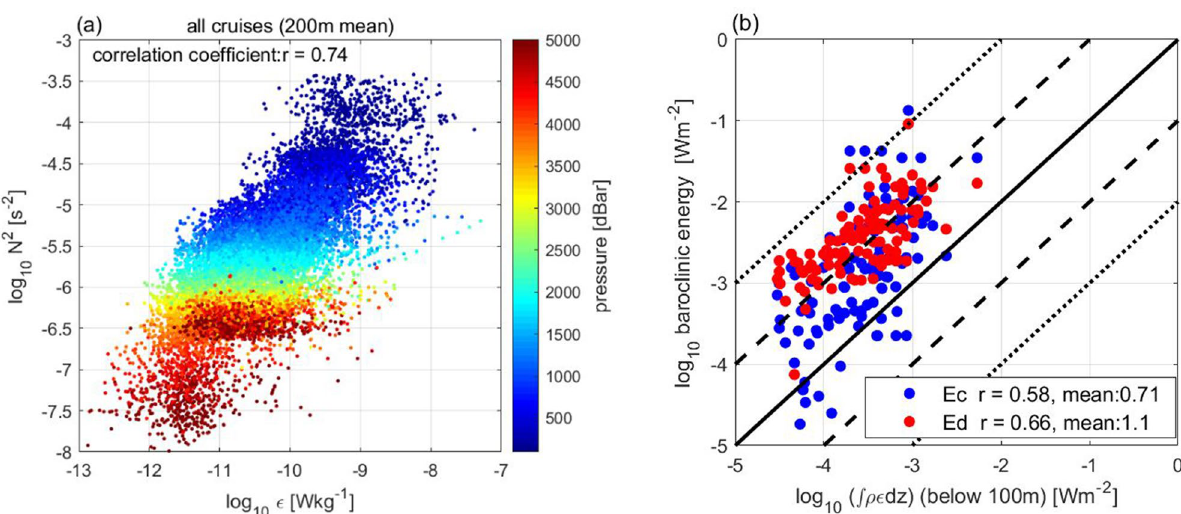
Figure 3. Relationship between ε and N 2 and baroclinic tide energy. ( a ) Relationship between the observed energy dissipation, ε , and the squared buoyancy frequency, N 2 . Colours denote pressure. ( b ) Relationship between depth-integrated observed energy dissipation, ∫ ρε d z , and model-based depth-integrated baroclinic energy conversion rate, Ec (blue dots), representing the generation of internal waves by tidal forcing, and the relationship between ∫ ρε d z and depth-integrated tide-induced energy dissipation, Ed (red dots), both correspond to MR-14-04 and RF16-06. X-axis: depth-integrated ρε from a 100-m depth to the bottom, excluding the surface 100-m layer to avoid the influence of wind. Y-axis: Ec and Ed are estimated in the model 2 based on the 3-D tide-driven model 3 . Ec and Ed simulated with the resolution (1/15°) model are multiplied by 1.5 as in the model 2 . “r” in the legend represents the correlation coefficient in logarithmic scale and “mean” is the average of